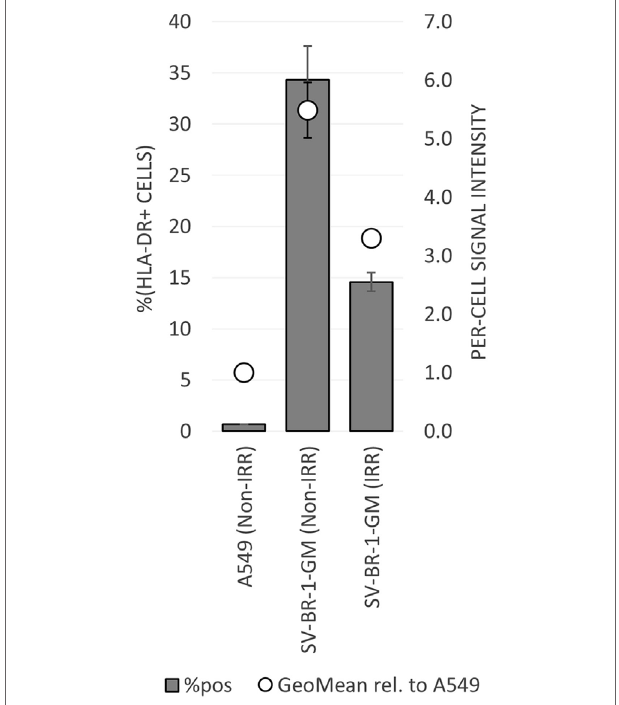
FigUre 5 | HLA-DR expression on irradiated and nonirradiated SV-BR-1- GM cells. SV-BR-1-GM cells were stained with a FITC-conjugated mouse monoclonal anti-HLA-DR antibody (clone L243) recognizing an epitope from HLA-DR α only present when complexed with an HLA-DR β chain. Shown are arithmetic means ± SDs of technical triplicates (SV-BR-1-GM) or duplicates (A549) from (i) the percentages of HLA-DR positive cells (left axis) and (ii) the per-cell HLA-DR signal intensities normalized to the geometric mean of the signal intensity by the A549 negative control and reference cell line (value of A549 = 1) (right axis) (86, 87) Non-IRR, non-irradiated; IRR,